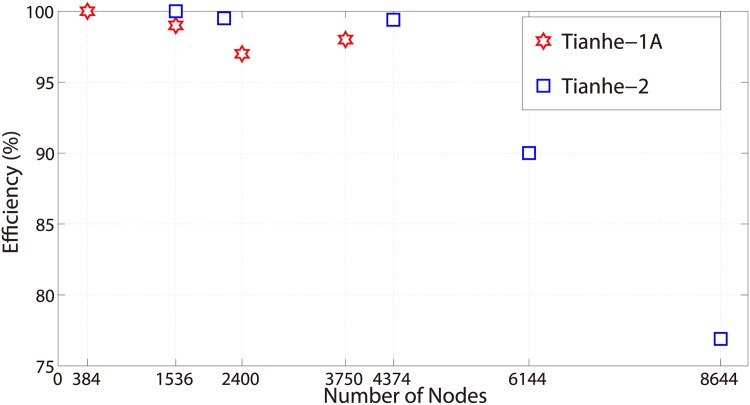
Strong scaling efficiency on Tianhe-1A and Tianhe-2.